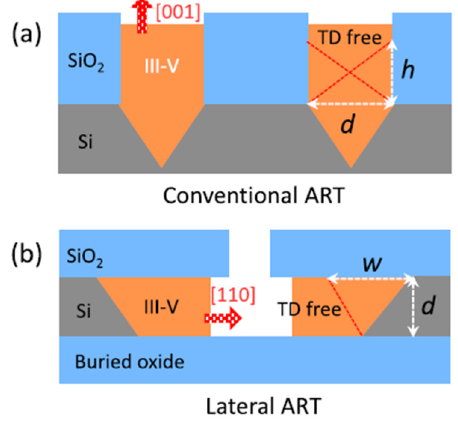
Figure 12. ( a ) Schematic of conventional ART technique. The epitaxy proceeds along [001] direction. ( b ) Schematic of defect trapping and growth mechanism of lateral ART technique. The growth was along the [110] direction. Reprinted with permission from ref. [60] © AIP Publishing. Copyright 2019 Applied Physics